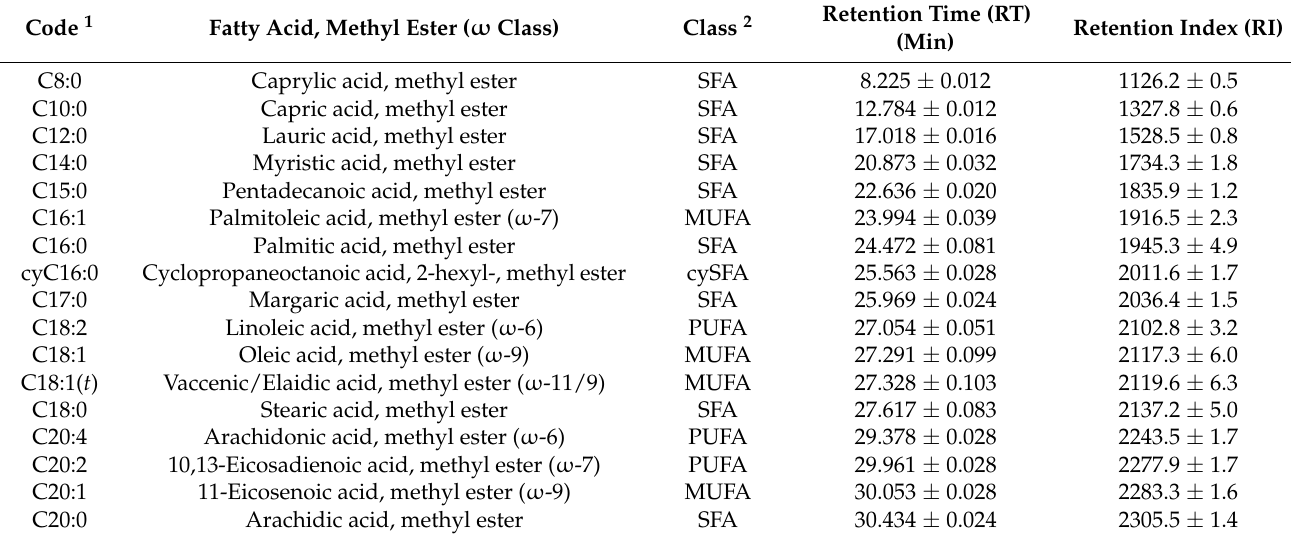
Table 1. The codes of the main FAMEs identified by GC-MS in the derivatized Mangalitza lipid fractions. Retention time (RT) and retention index (RI) values have also been presented. RIs have been calculated on the basis of GC-MS data obtained for a C 8 -C 20 linear alkane standard